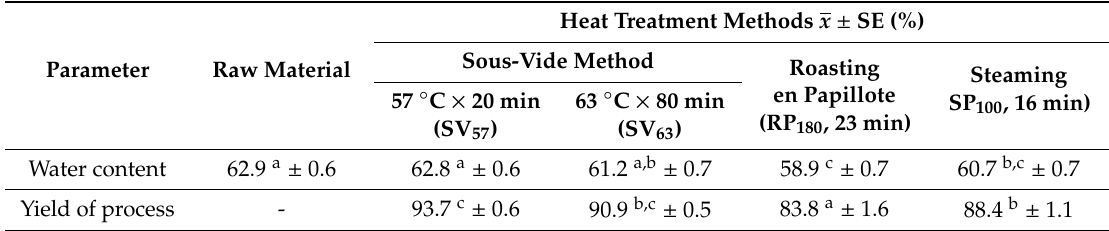
Table 2. Water content and yield of process in salmon after heat treatment by di ff erent methods.